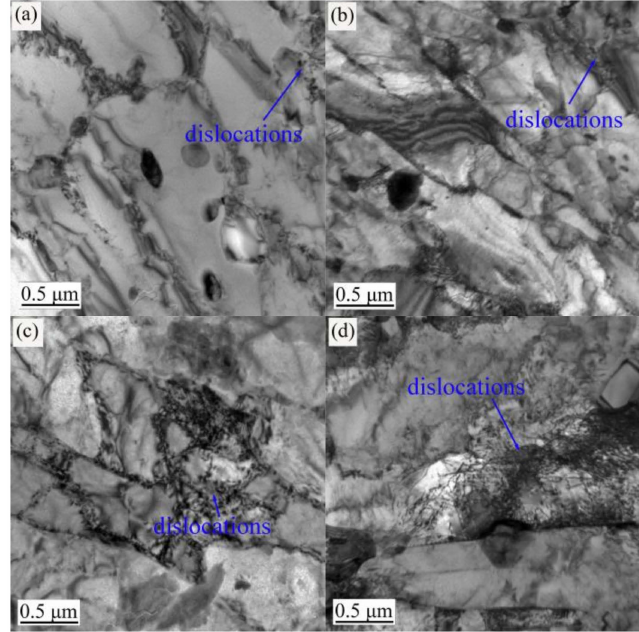
Figure 5. TEM observations of the 700 ◦ C-tempered AISI 420 steel after proton radiation with di ff erent cumulative charges ( a ) 0 p / cm 2 ; ( b ) 2 × 10 14 p / cm 2 ; ( c ) 2 × 10 15 p / cm 2 ; ( d ) 2 × 10 16 p / cm 2